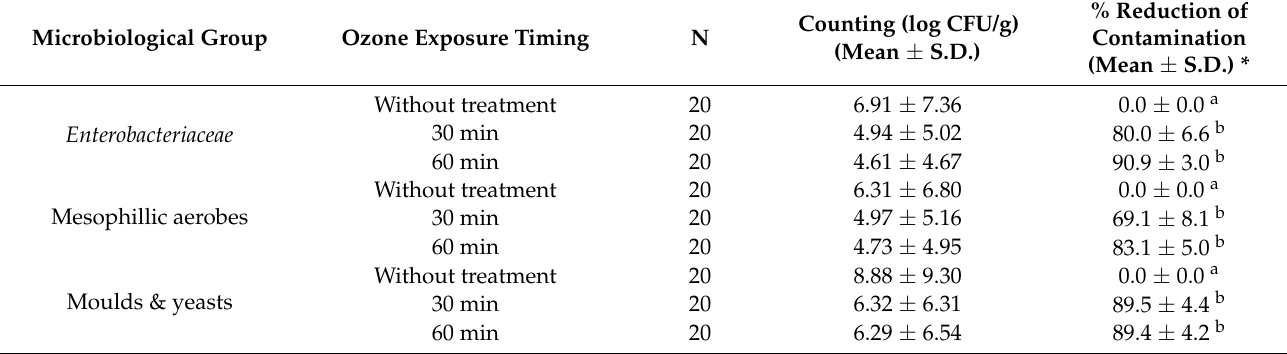
Table 3. Microbial load reduction obtained from bee-pollen directly exposed to ozone (output: 200 mg/h). The results are expressed as number of samples (N), average of CFU counted, and percentage of microbial load reduction (mean ± S.D.).